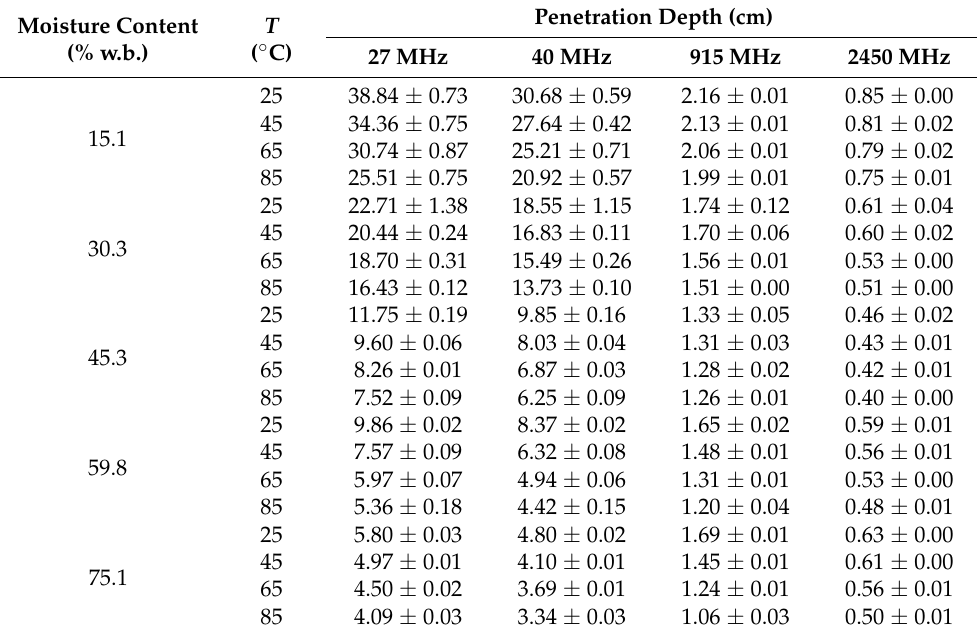
Table 5. Penetration depth of electromagnetic waves into wolfberries at different frequencies, mois- ture contents, and temperatures ( T , ◦